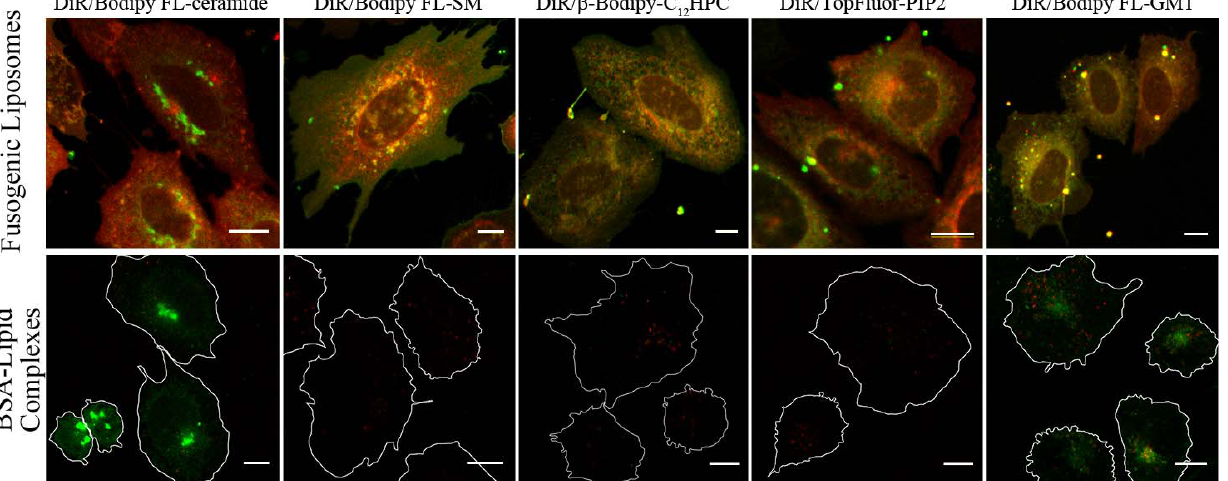
(Figure 4: 24 h). Additional 24 h later some weak endoplasmic reticulum and strong lysosome like staining were observed (compare Figure 4: 48 h and Figure 2c).